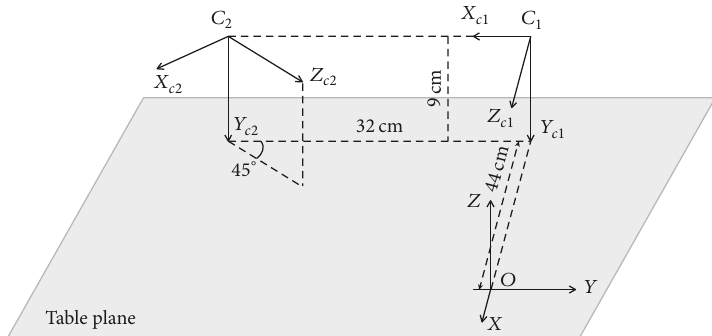
Figure 2: Schematics of spatial relationship of camera 𝐶 1 and camera 𝐶 2 with respect to world coordinates with origin at 𝑂 .